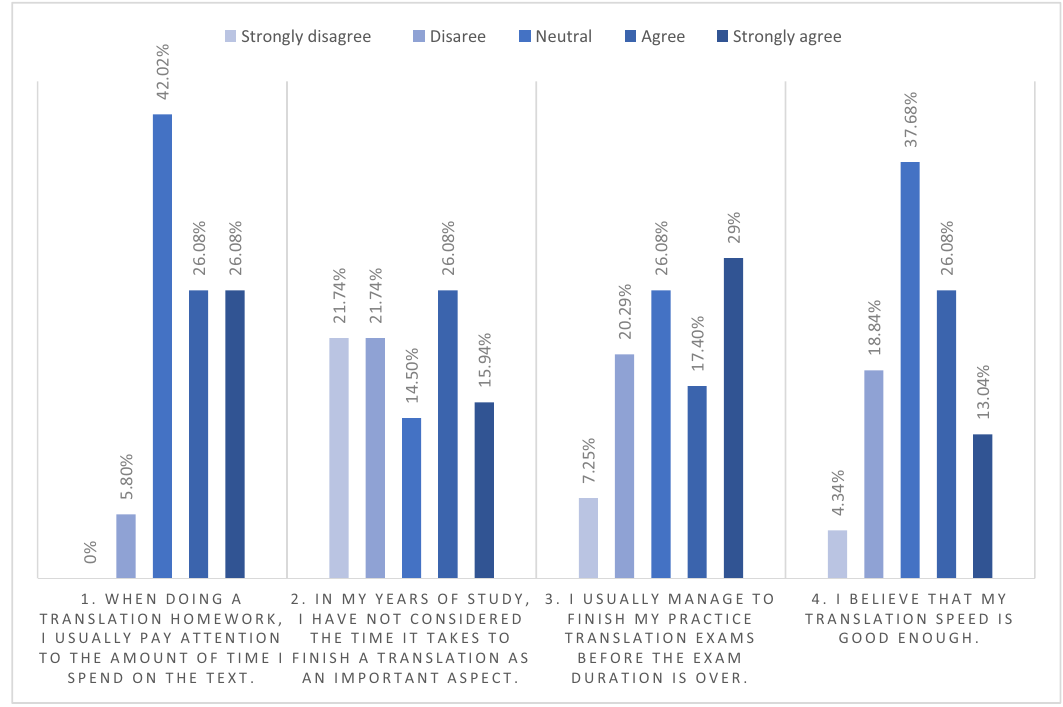
Figure 1: Speed and the students. This fi gure provides the results of responses to the four items focusing on the students ’ handling of time in their translation